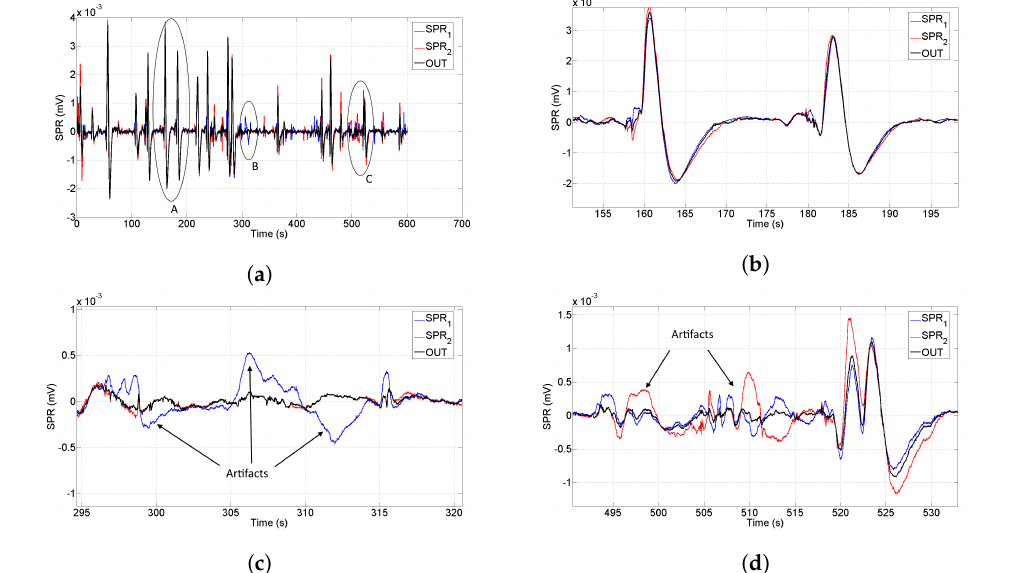
Figure 11. ( a ) Acquired SPR signals (blue line SPR 1 on right hand, red line SPR 2 on left hand) and output of the algorithm for motion artifact removal (black line) during a driving session; circles A, B and C represent some significant portions zoomed in the next sub-figures. ( b ) Zoom of the signals in the circle A; when hands are still, the three traces are identical and SPR pulses look with smooth shape. ( c ) Zoom of the signals in the circle B; it is evident a motion artifact in right hand, but the output is not affected remaining close to zero. ( d ) Zoom of the signals in the circle C; motion artifacts are evident in both hands in t ∈ [ 495,515 ] s, but the output is not affected; at t = 520 s instead, an SPR pulse is properly